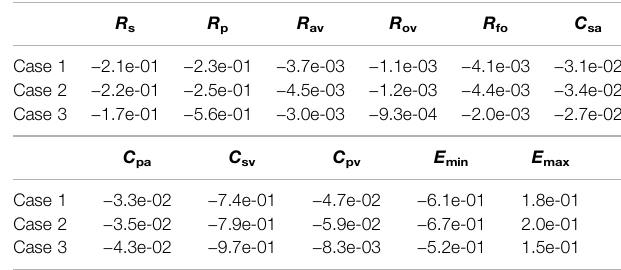
TABLE 5 | Sensitivities for cases 1, 2, and 3 computed for the systemic oxygen